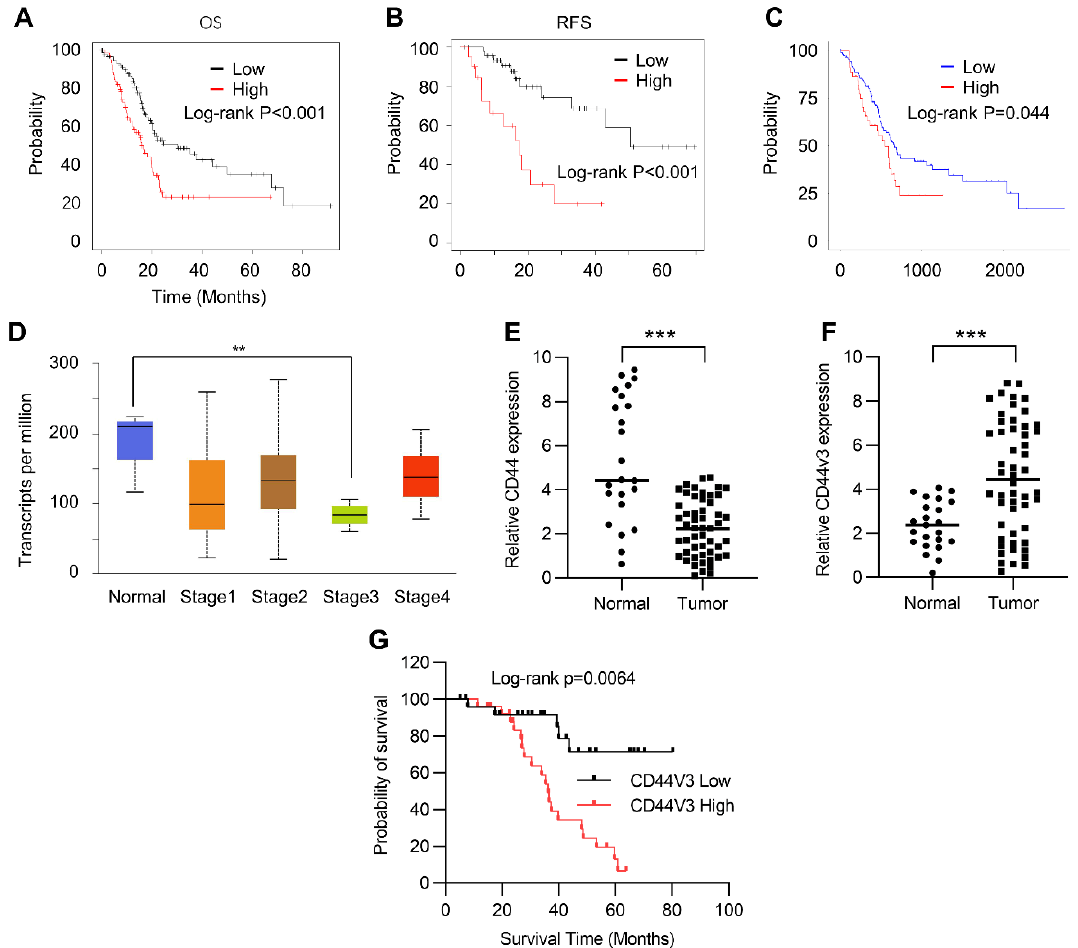
Figure 1. CD44 was correlated with a poor prognosis of pancreatic cancer. ( A ) Kaplan–Meier plots of overall survival in pancreatic cancer patients stratified according to their CD44 levels. The Kaplan – Meier plotter was used to analyze the data. ( B ) Kaplan – Meier plots of release-free survival in pancreatic cancer patients stratified according to their CD44 levels. The Kaplan – Meier plotter was used to analyze the data. ( C ) Kaplan – Meier plots of overall survival in pancreatic cancer patients stratified according to their CD44 levels. The data was analyzed in TCGA dataset from ualcan (http://ualcan.path.uab.edu, accessed on 8 May 2021). ( D ) CD44 levels in normal and pancreatic tumor tissues at various stages. The data was analyzed using the TCGA dataset from ualcan (http://ualcan.path.uab.edu, accessed on 8 May 2021). ( E ) The CD44 levels in normal and pancreatic tumor tissues were analyzed by qPCR. ( F ) The CD44V3 levels in normal and pancreatic tumor tissues were analyzed by qPCR. ( G ) Kaplan – Meier plots of overall survival in pancreatic cancer patients stratified according to their CD44V3 levels. The data are presented as mean ± S.D. ** p < 0.01; *** p < 0.001.